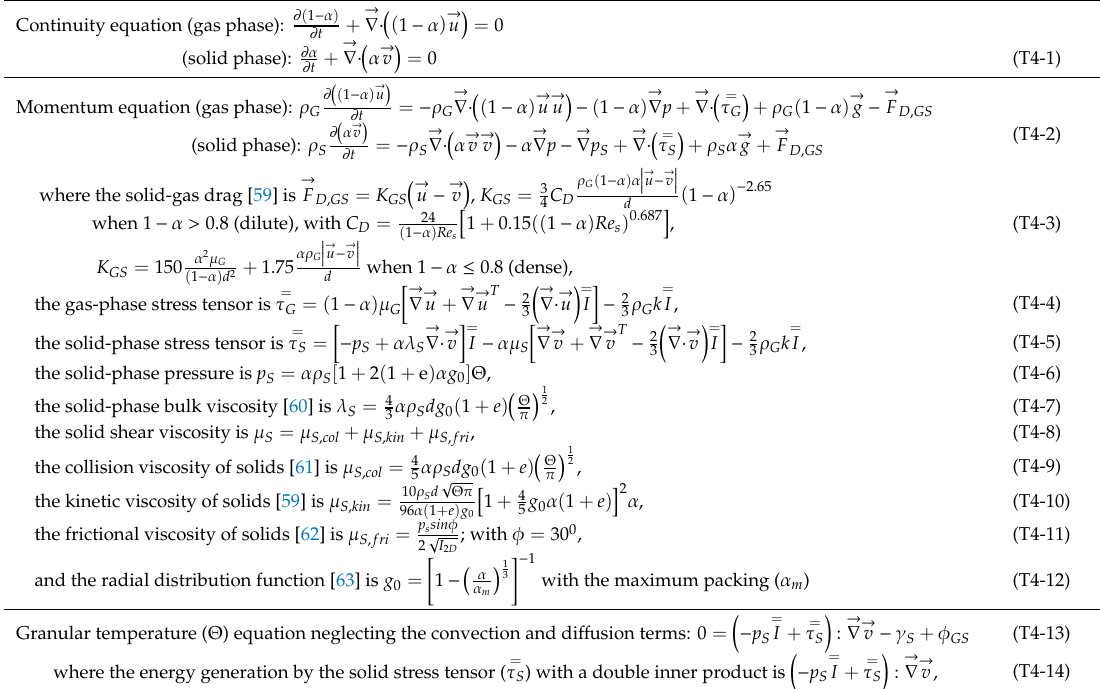
Table 4. Kinetic theory of granular flow (KTGF)-CFD model for gas-solid phases [55,58]. → ∂ ( 1 − α ) ∇· (cid:16) ( 1 − α ) → u (cid:17) = Continuity equation (gas phase): ∂ t +